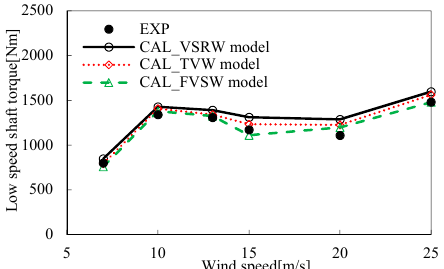
Figure 11. Measured and calculated results of LSST of NREL Phase VI wind turbine for wind speeds ranging from 7 m/s to 25